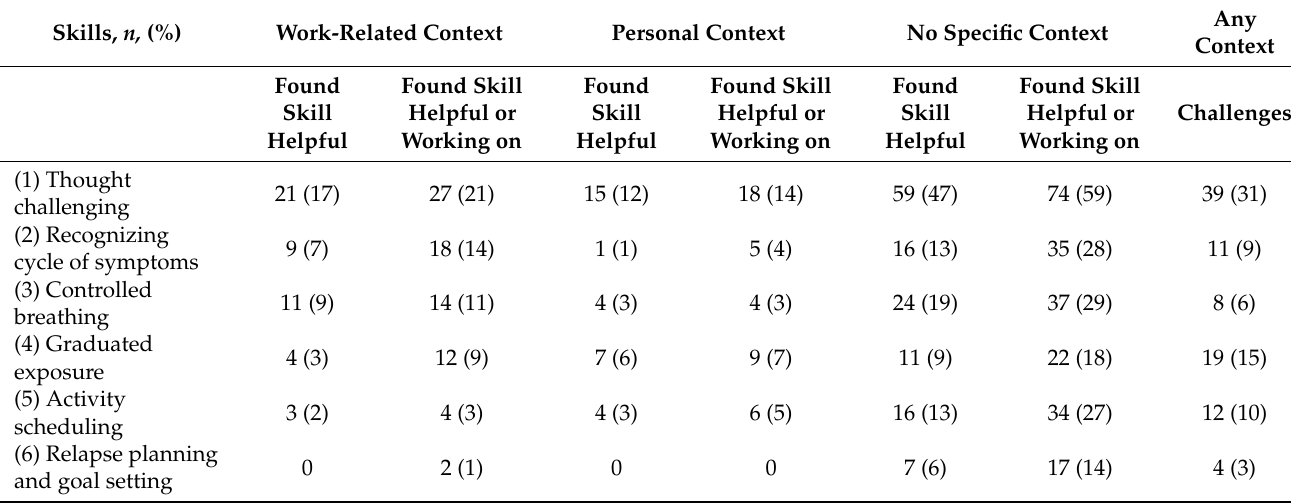
Table 5. Skills that clients found helpful, found helpful or were working on without necessarily finding them helpful, or found challenging ( N =